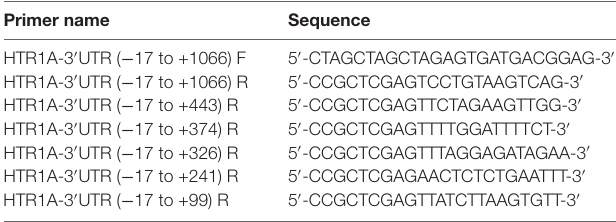
TABLE 1 | PCR primer